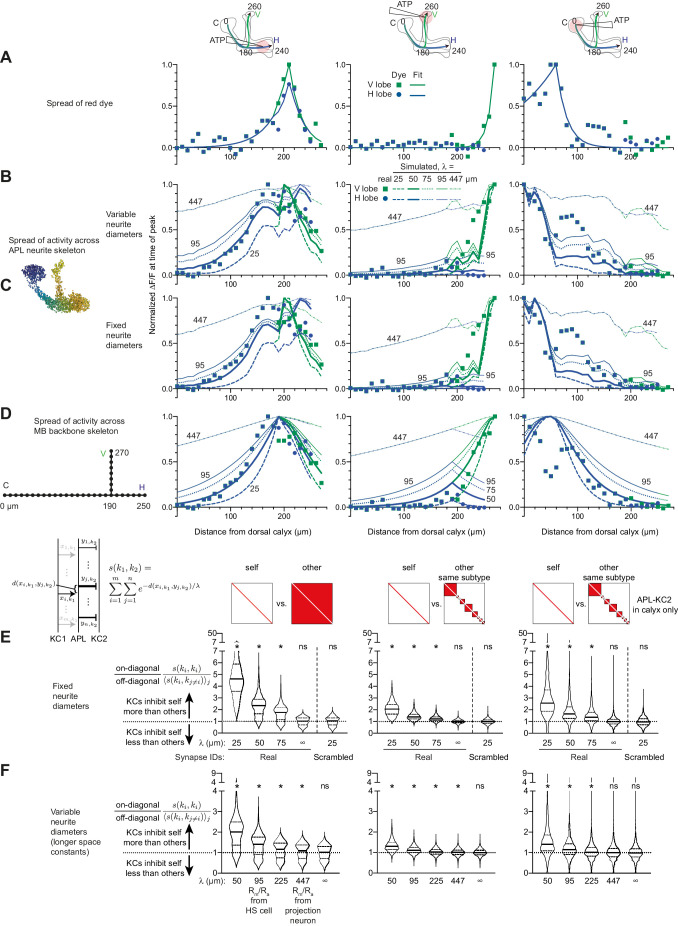
Additional data for Figure 8.(A–D) Simulating local activation of APL with different space constants. Some curves have their space constants annotated for clarity (A) repeated from Figure 8E for comparison. (B) Simulated activity as in Figure 8F; simulated activity spreads farther than experimental activity spread when using longer space constants derived from published estimates of RmRa (λ = 95 µm derived from HS cells, or 447 µm derived from a projection neuron). (C) As in B but treating all APL neurites as having the same diameter (see Materials and methods). Simulated activity spreads somewhat further than in B, likely because the very thin APL neurites are likely ‘branches’ rather than ‘main trunk’ neurites along which signals would have to travel to go across the neuron. (D) Simulated activity ignoring APL neurite morphology, treating the Voronoi cells as points on perpendicular straight lines. The same exponential decay applies as in B, except that the distance between points is the cityblock distance, that is, the distance along the backbone skeleton, not the APL’s neurite skeleton (as in B–C): activity(si)=∑j=1nw(si,sj). Note that 50 µm gives the best fit for horizontal lobe and calyx stimulation, while 25 µm gives the best fit for vertical lobe stimulation. (E) As Figure 8K–M, except treating all APL neurites as having the same diameter. (F) As Figure 8K–M, except including longer space constants (50 µm and infinity repeated for comparison). Significant imbalance in self vs. other inhibition remains even at λ = 95 and 225 µm.Figure 8—figure supplement 2—source data 1.Source data for Figure 8—figure supplement 2.